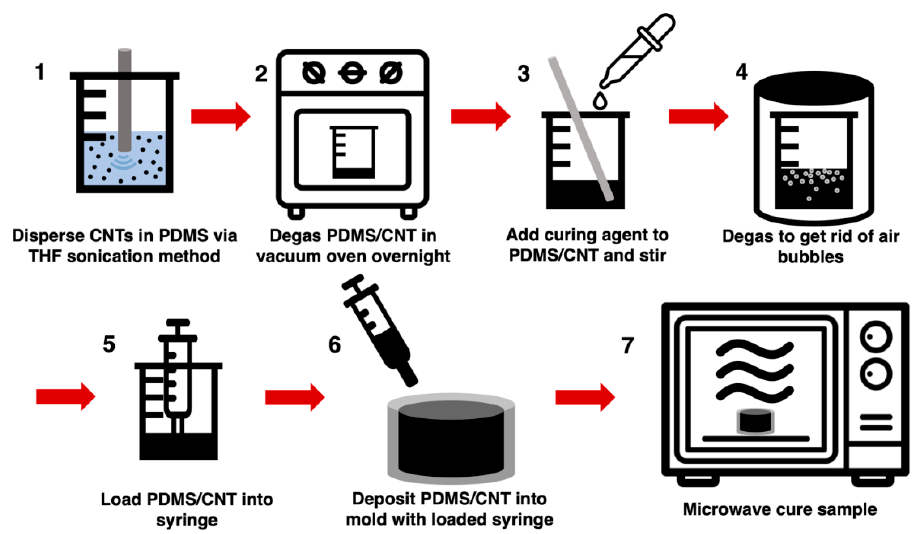
Figure 1. Schematic of sample fabrication method for m-PDMS/CNT.